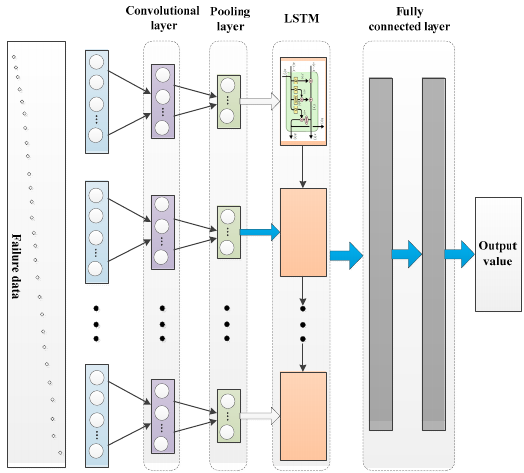
Figure 7. The architecture of a convolutional LSTM neural network (CLNN).